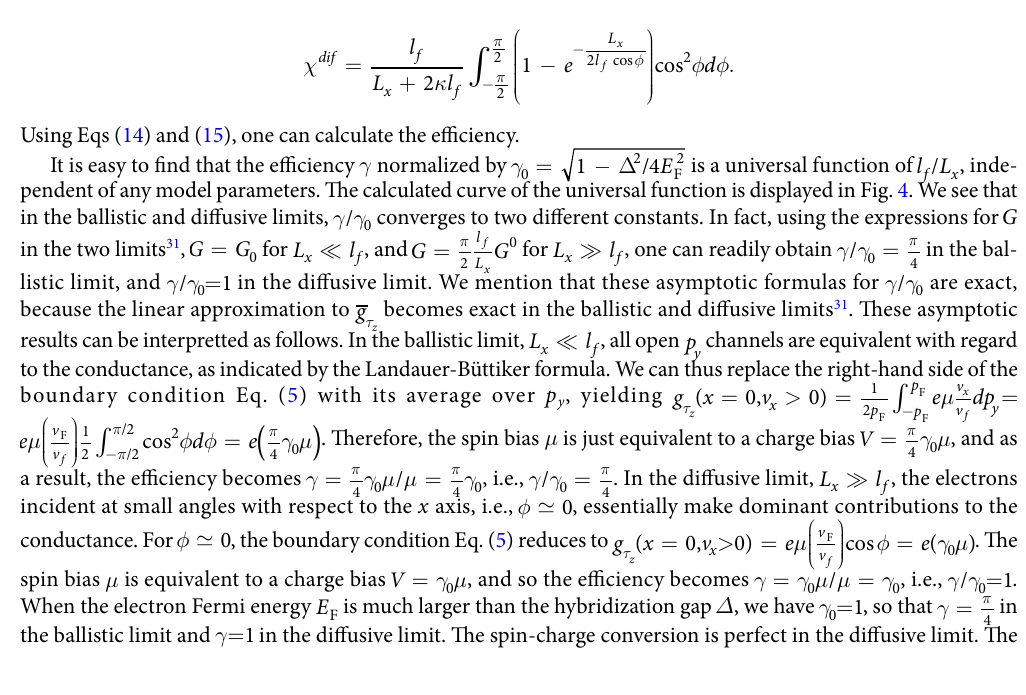
. In the diffusive limit,  L l 4